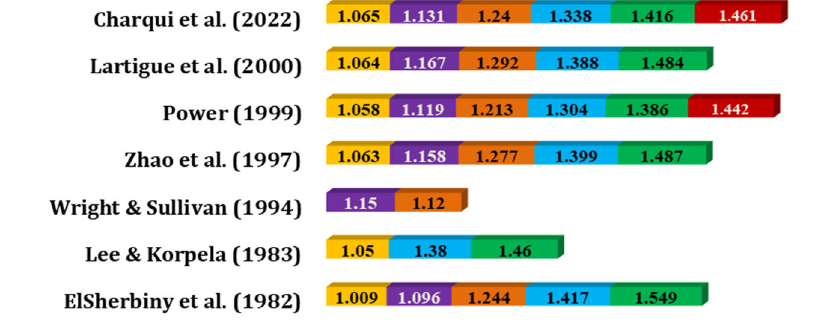
Figure 7. Variation of Nu avg with different Ra for A = 40 [186,279–284].